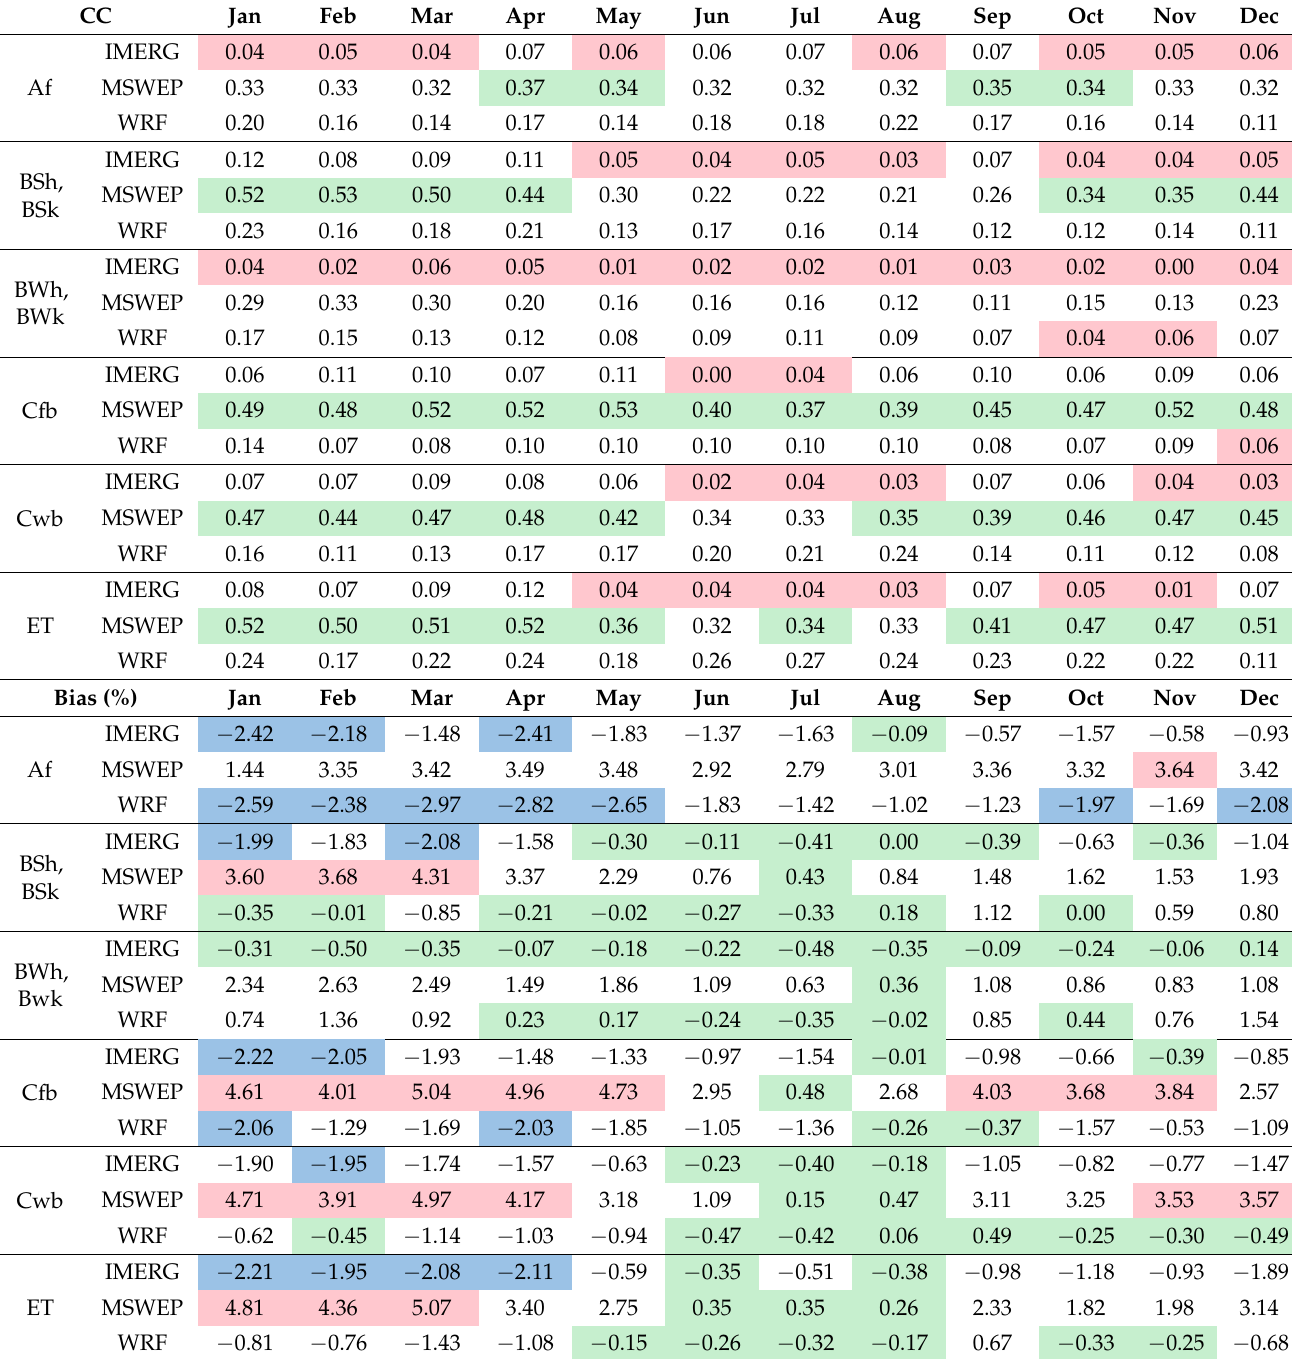
Table 5. Monthly average statistical results for 2010–2018 for precipitation products in six major climate zones in Peru, where red or blue indicated poor performance and green indicated closer to optimal